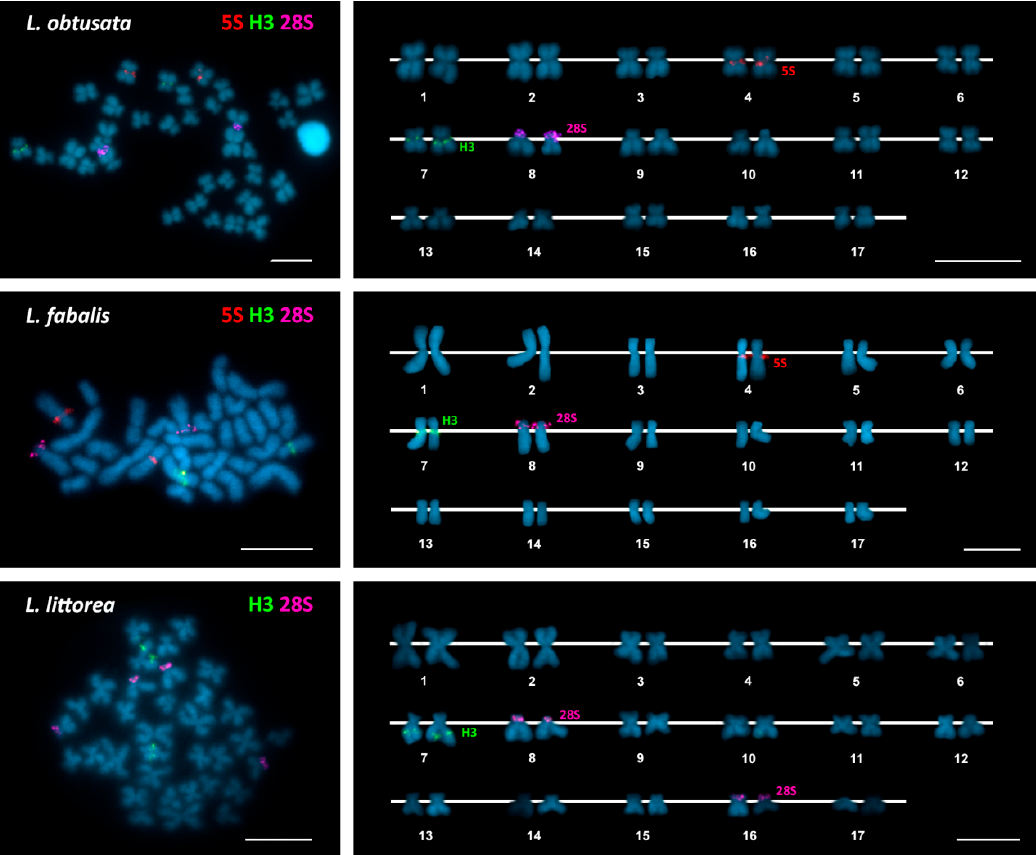
Figure 2. Chromosomal mapping of rDNA and histone gene clusters in flat and common periwinkles. Fluorescent in situ hybridization mapping of minor rDNA (5S, red), H3 histone gene (H3, green) and major rDNA (28S, magenta) probes to mitotic chromosomes of the flat periwinkles Littorina obtusata and Littorina fabalis and the common periwinkle Littorina littorea counterstained with 4 ′ -6-diamidino-2-phenylindole (DAPI). No minor (5S) rDNA signals were detected in the common periwinkle. Scale bars, 5 μ m.